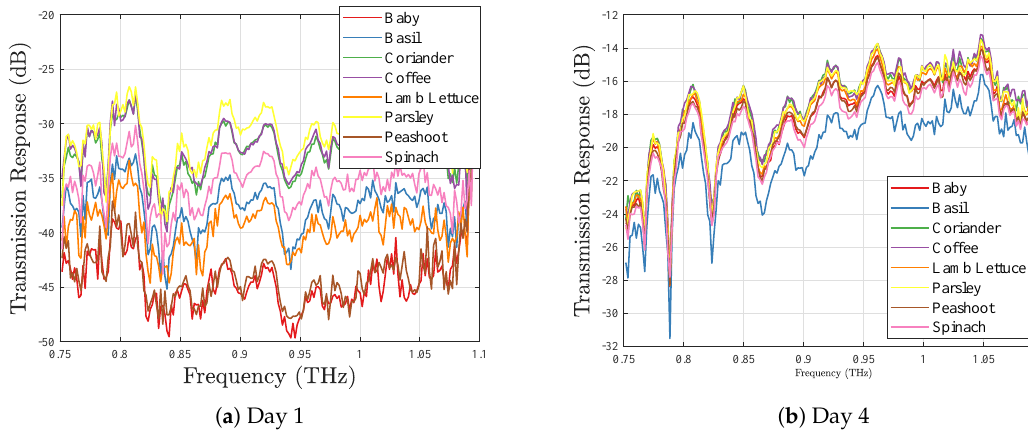
Figure 7. Transmission response of leaves on first and fourth